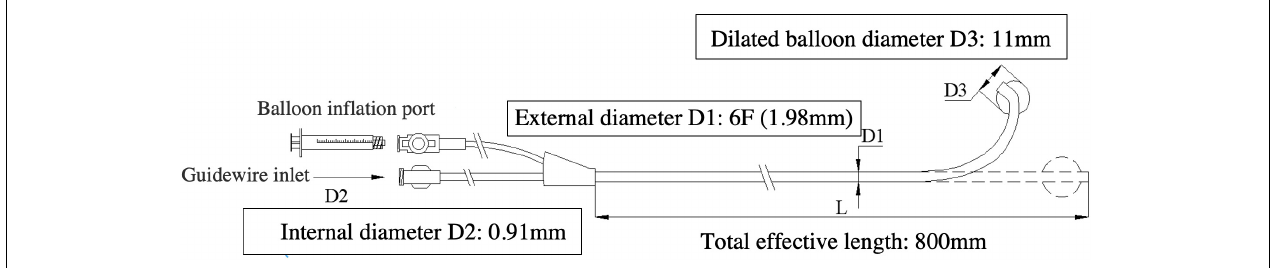
FIGURE 1 | The Lee’s venogram balloon catheter (6F-11 mm-CS) with coronary sinus shaping, has an open lumen, over-the-wire design, which tracks over the guidewire and allows access to any site of the coronary vein system. Schematic diagram of the Lee’s venogram balloon with: balloon inflation port and guidewire port for access to central lumen. TABLE 1 | Baseline clinical data of the five patients.